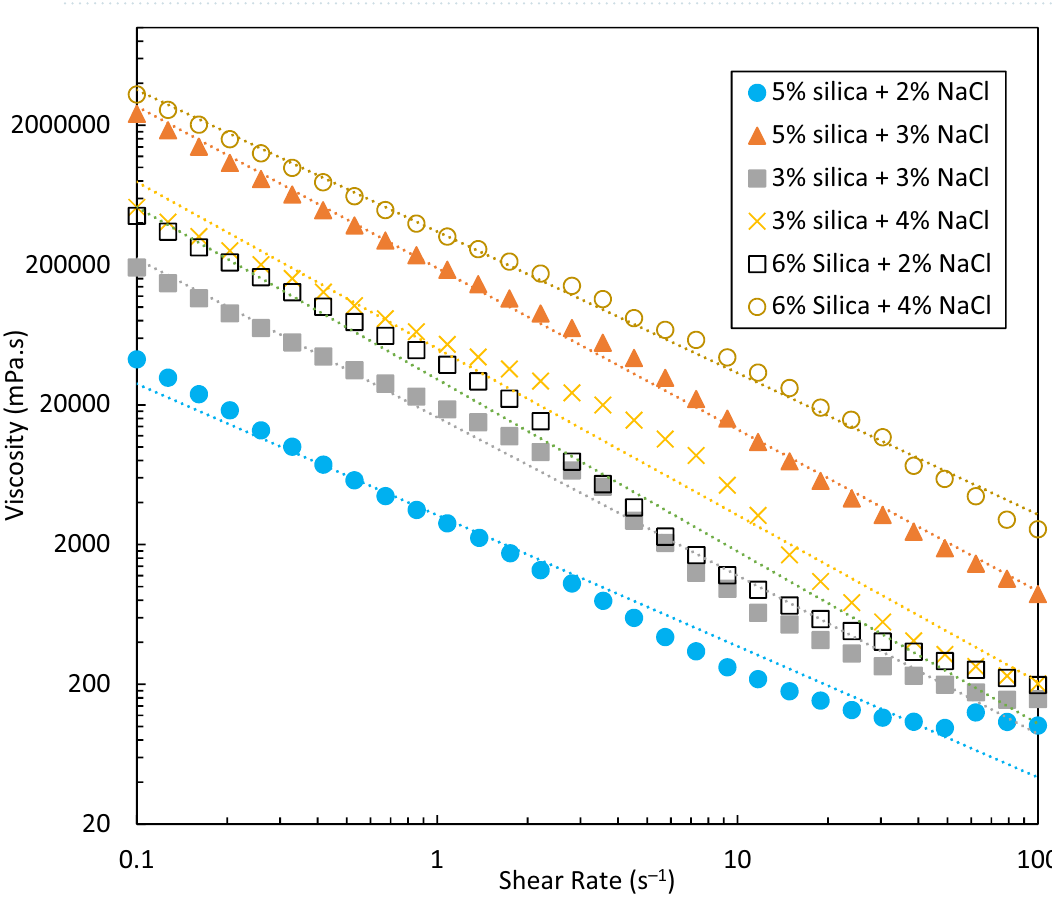
Figure 8. Effect of type of cation (Na + or Mg 2+ ) at different ionic strengths on the final status of the dispersions standing at room temperature of 20–25 °C after 24 h.